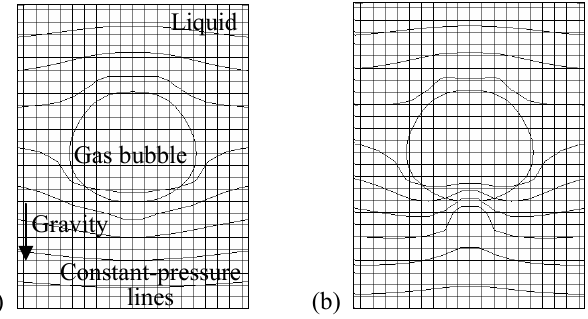
Fig. 1 Unphysical pressure distribution caused by inappropriate momentum transport: (a) time level n , (b) time level n